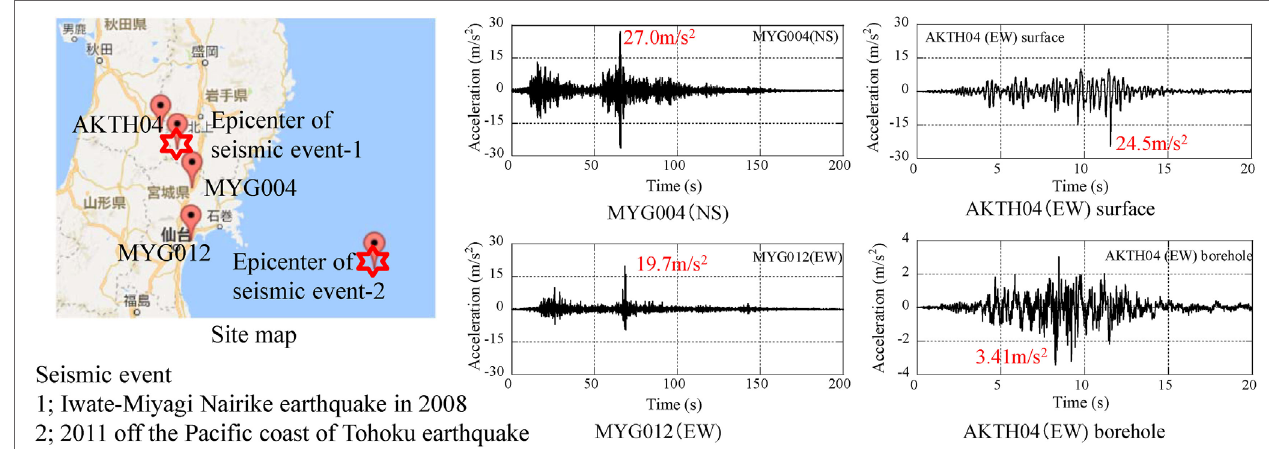
FigUre 1 | Seismic records with peak value over 20 m/s 2 .